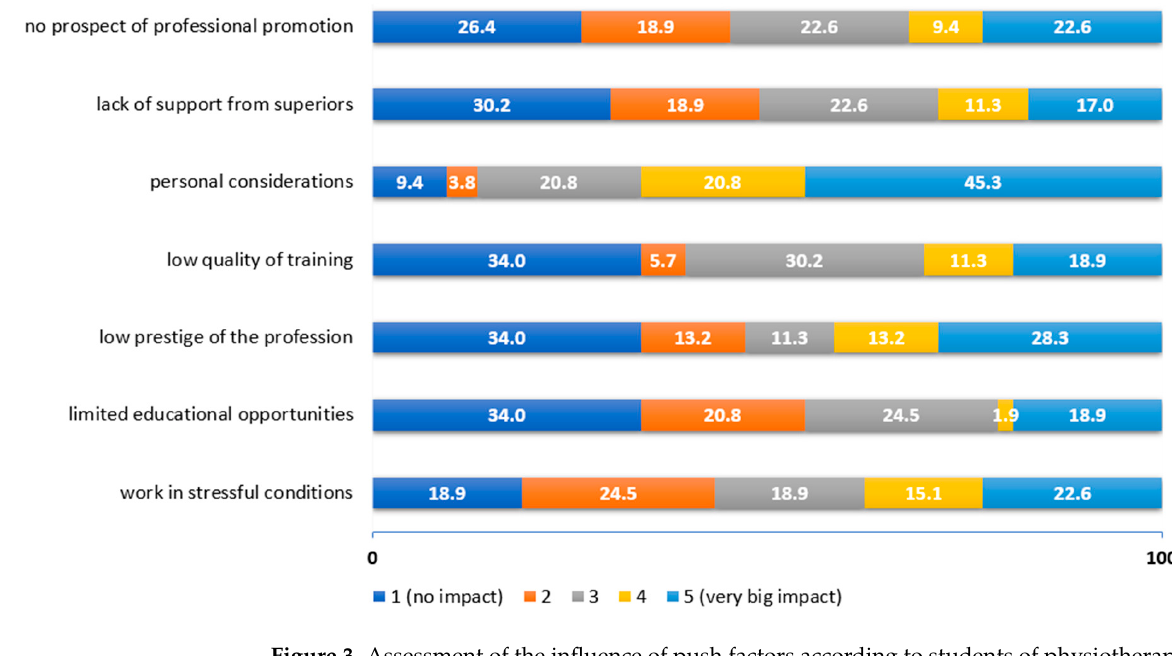
Figure 3. Assessment of the influence of push factors according to students of physiotherapy.